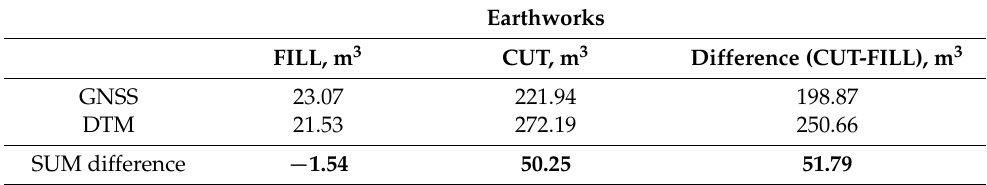
Table 5. Summary data on earthworks of Fill and Cut on the designed forest/skid